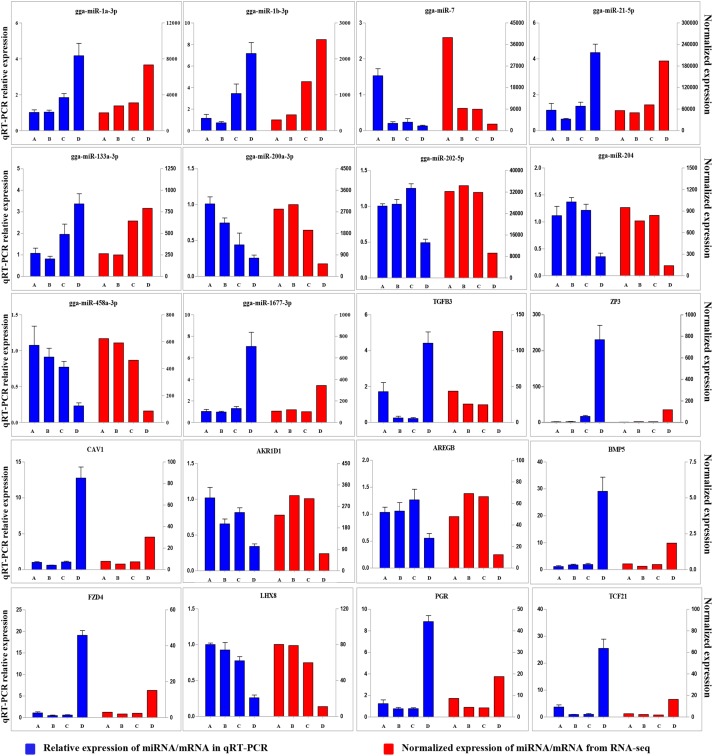
Comparison of expression levels for 10 miRNAs and 10 mRNAs determined using qRT-PCR and RNA-seq. Four samples at each stage were pooled for RNA-seq and four chickens from an independent cohort of animals were used for qRT-PCR. qRT-PCR values are shown as mean ± SD of four measurements, using U6 snRNA and GAPDH as internal standards.